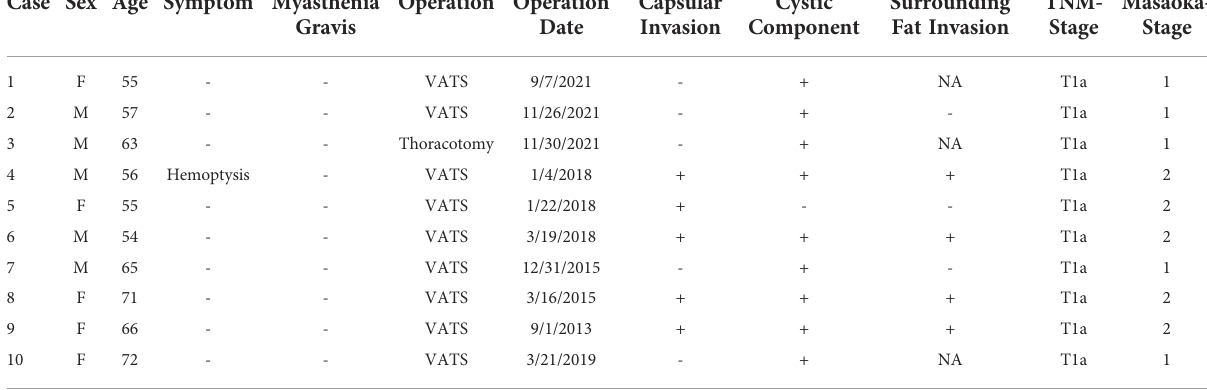
TABLE 1 Clinical and Pathological Features of MTWLS. Case Sex Age Symptom